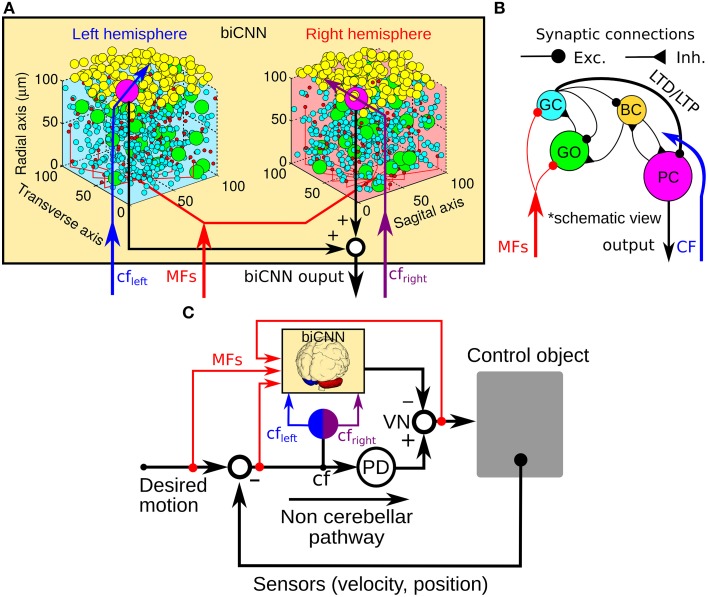
General scheme of the biCNN model and its configuration for robot control. (A) Right and left hemispheres of the biCNN model allocated in a 3D space. (B) Synaptic connections included in the biCNN model. (C) Wiring of the biCNN model during motor control. BC, basket/stellate cells; CF, climbing fiber; Exc., excitatory synapse; Inh., inhibitory synapse; GC, granule cell; GO, Golgi cell; MFs, mossy fibers; LTD, long-term depression; LTP, long-term potentiation; PC, Purkinje cell; PD, proportional and derivative controller; VN, vestibular nucleus.